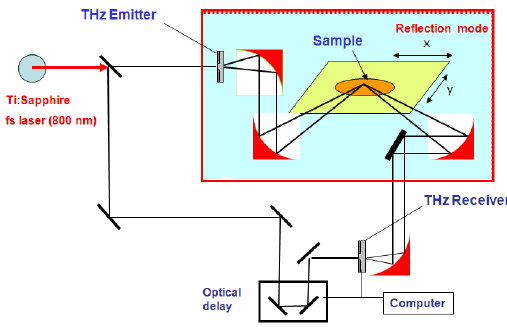
Figure 2. A photo of the THz-TDS system for imaging and measuring material parameters.